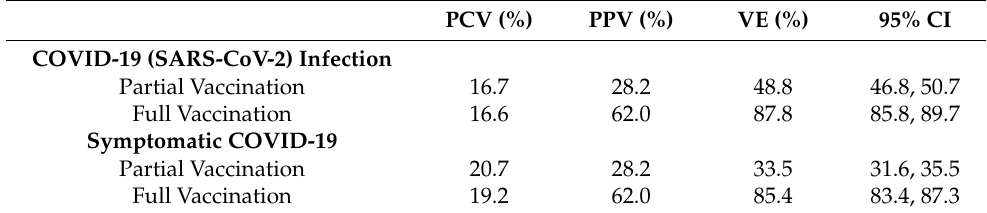
Table 1. Proportion of COVID-19 cases vaccinated and estimates of vaccine effectiveness using the screening